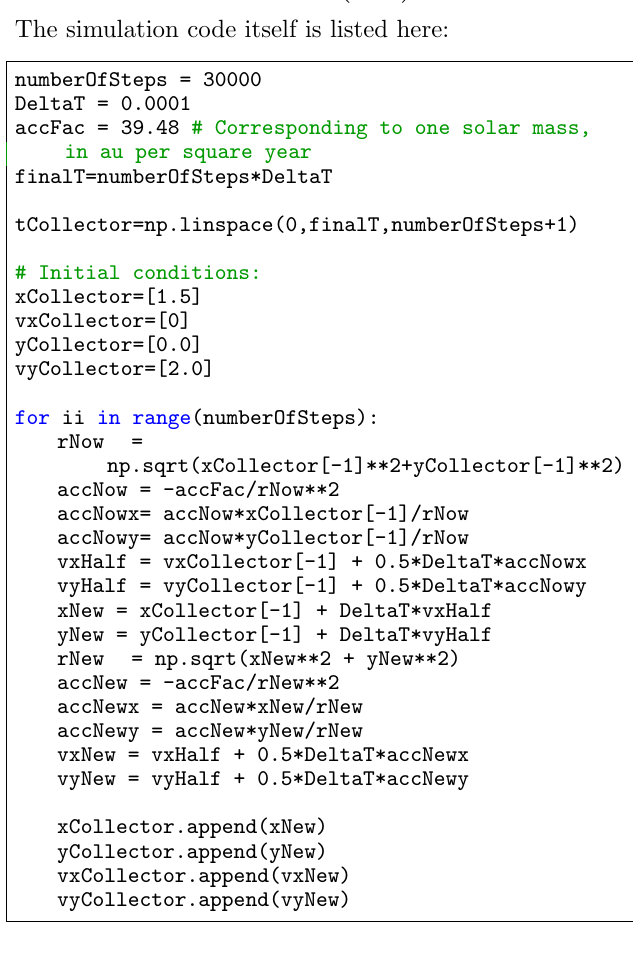
Fig. 107.— Orbit of a planet around a central mass, simulated with the velocity Verlet algorithm